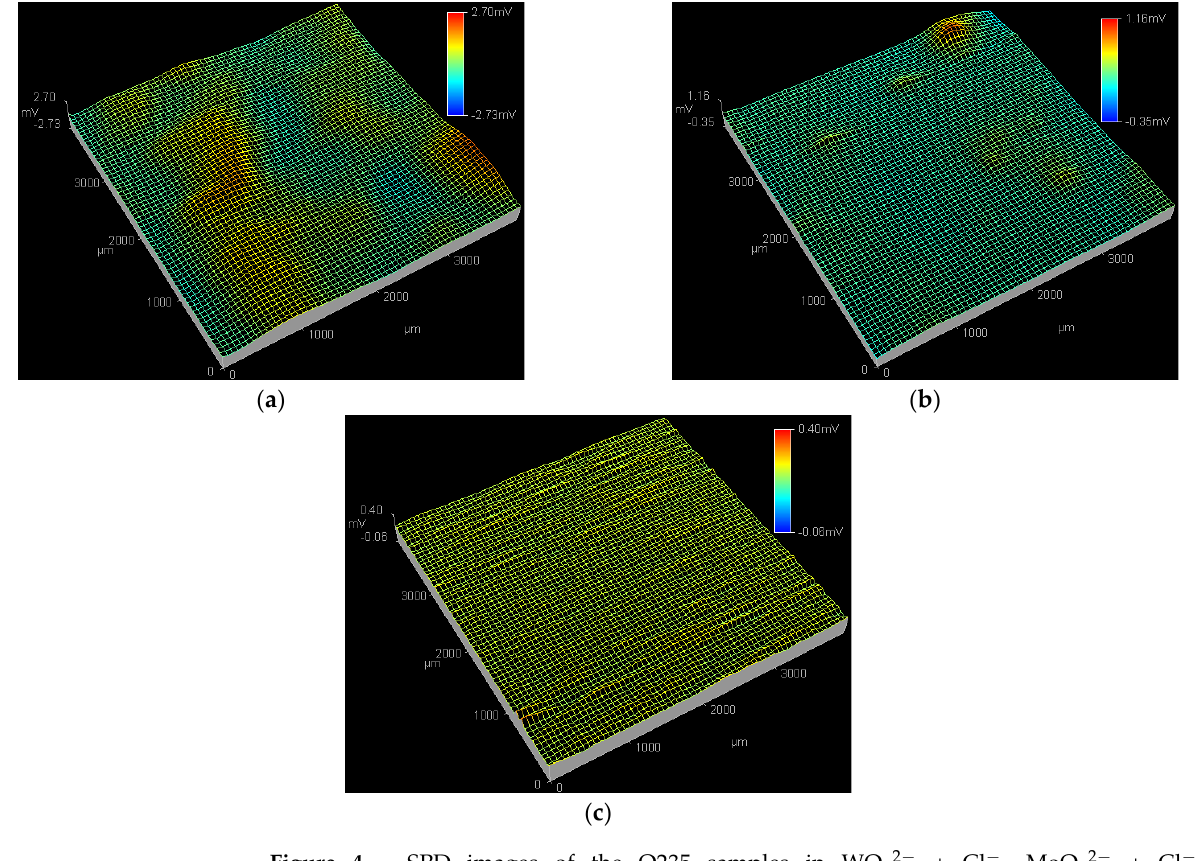
Figure 4. SPD images of the Q235 samples in WO 4 2− + Cl − , MoO 4 2− + Cl − and WO 4 2− + MoO 4 2− + Cl − solutions at applied potential of 0.09 V SCE : ( a ) WO 4 2− + Cl − solution, ( b ) MoO 4 2− + Cl − solution and ( c ) WO 4 2− + MoO 4 2− + Cl − solution.